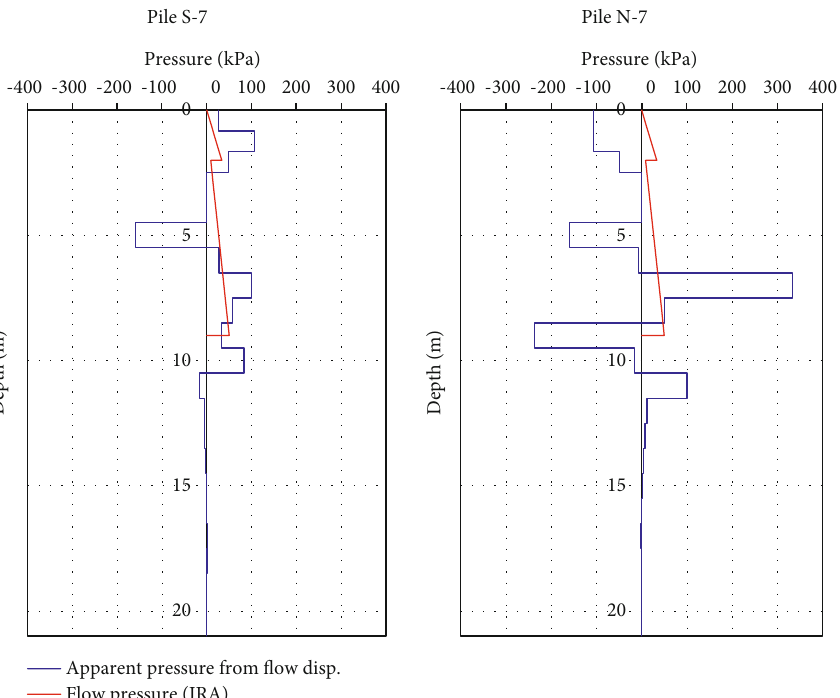
Figure 12: Comparison of apparent-pressure diagram from the displacement-based approach and the fl ow pressure used in the force-based